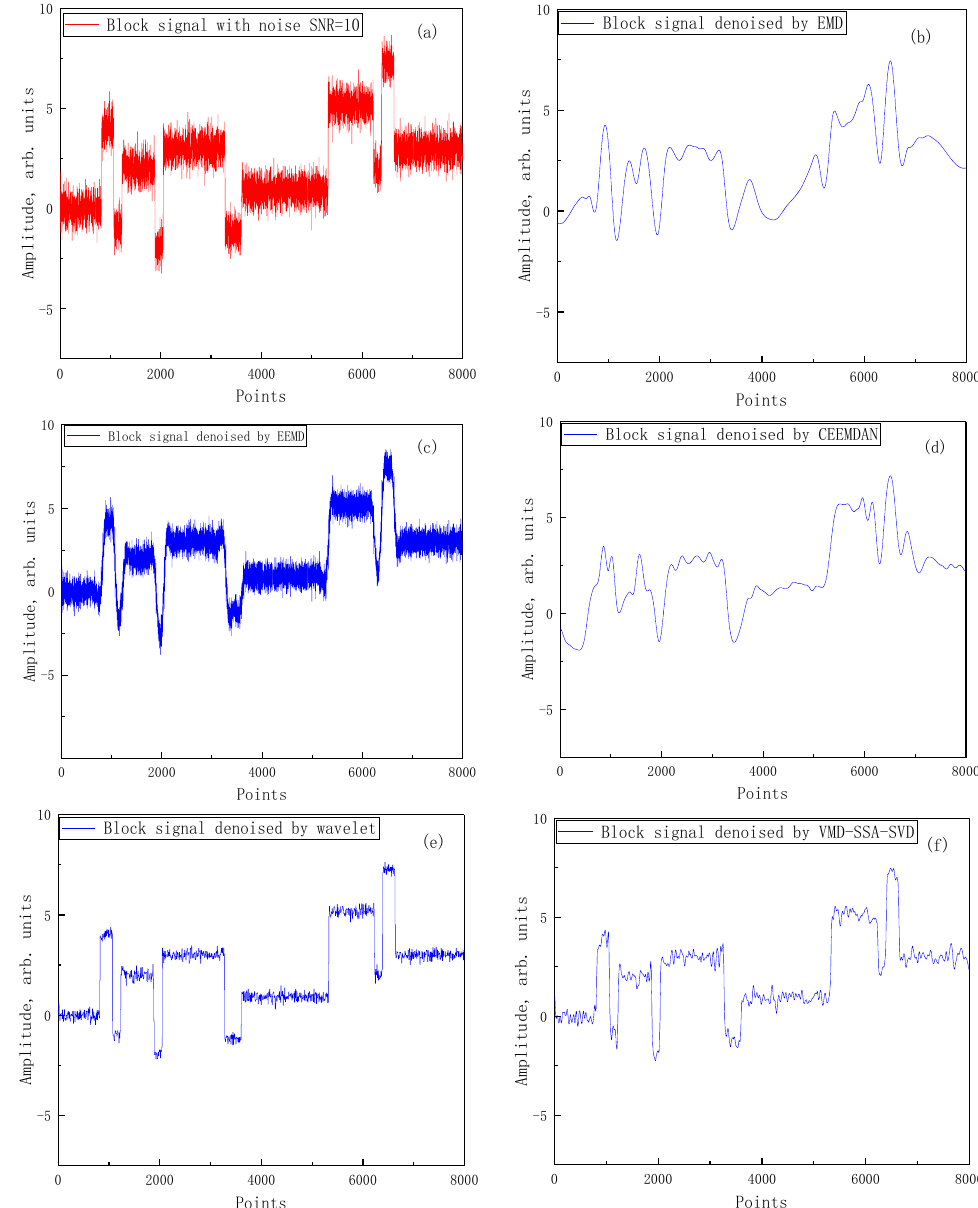
Figure 6. The simulated noise-reduction effects of Block signals. ( a ) Block signal with SNR = 10. ( b ) The signal processed by the EMD method. ( c ) The signal processed by the EEMD method. ( d ) The signal processed by the CEEMDAN method. ( e ) The signal processed by the wavelet threshold method. ( f ) The signal processed by the VMD-SSA-SVD method.